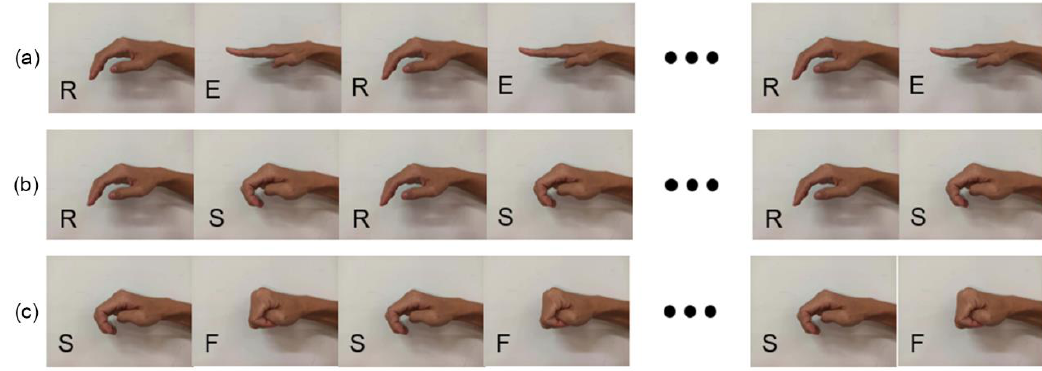
Figure 11. The designed hand motions sequences. ( a ) The motion sequence RE. ( b ) The motion sequence RS. ( c ) The motion sequence SF.